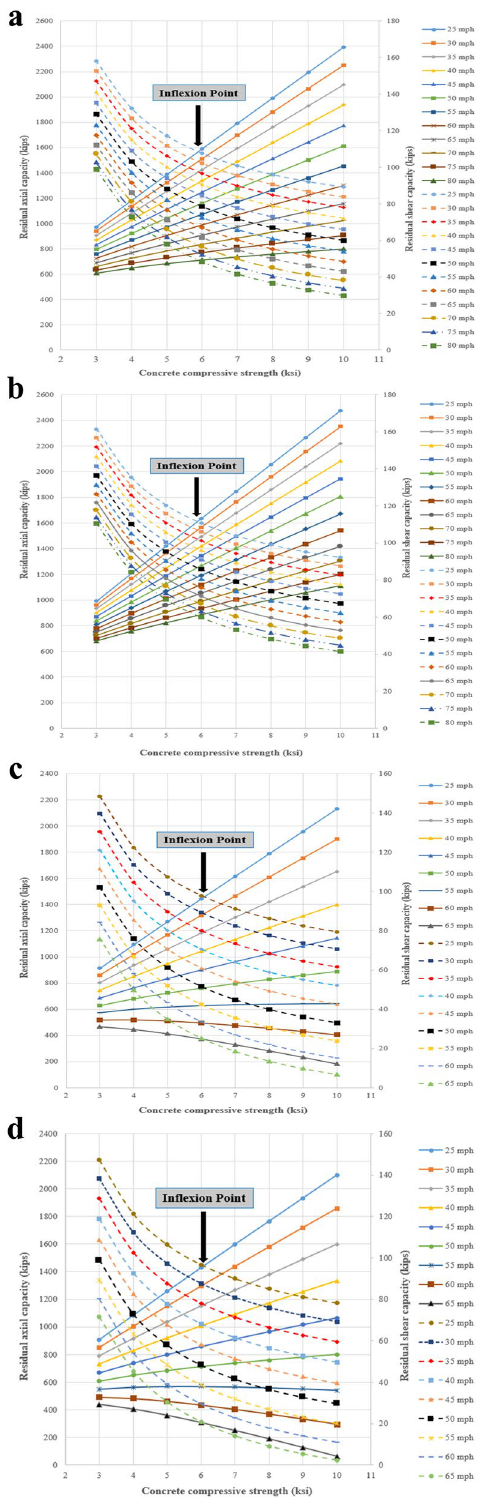
Fig. 4 a. Residual capacities showing inflexion point for Vehicle Class 5. b. Residual capacities showing inflexion point for Vehicle Class 6. c. Residual capacities showing inflexion point for Vehicle Class 7. d. Residual capacities showing inflexion point for Vehicle Class